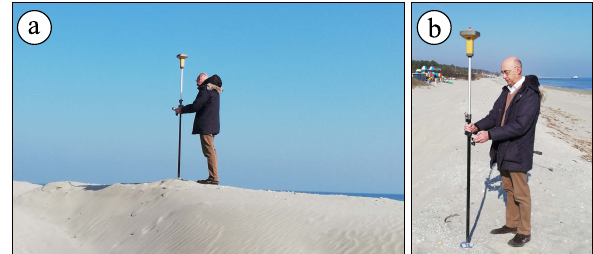
Figure 4. GNSS survey of validations points: (a) on the top of the dunes, (b) on the beach.